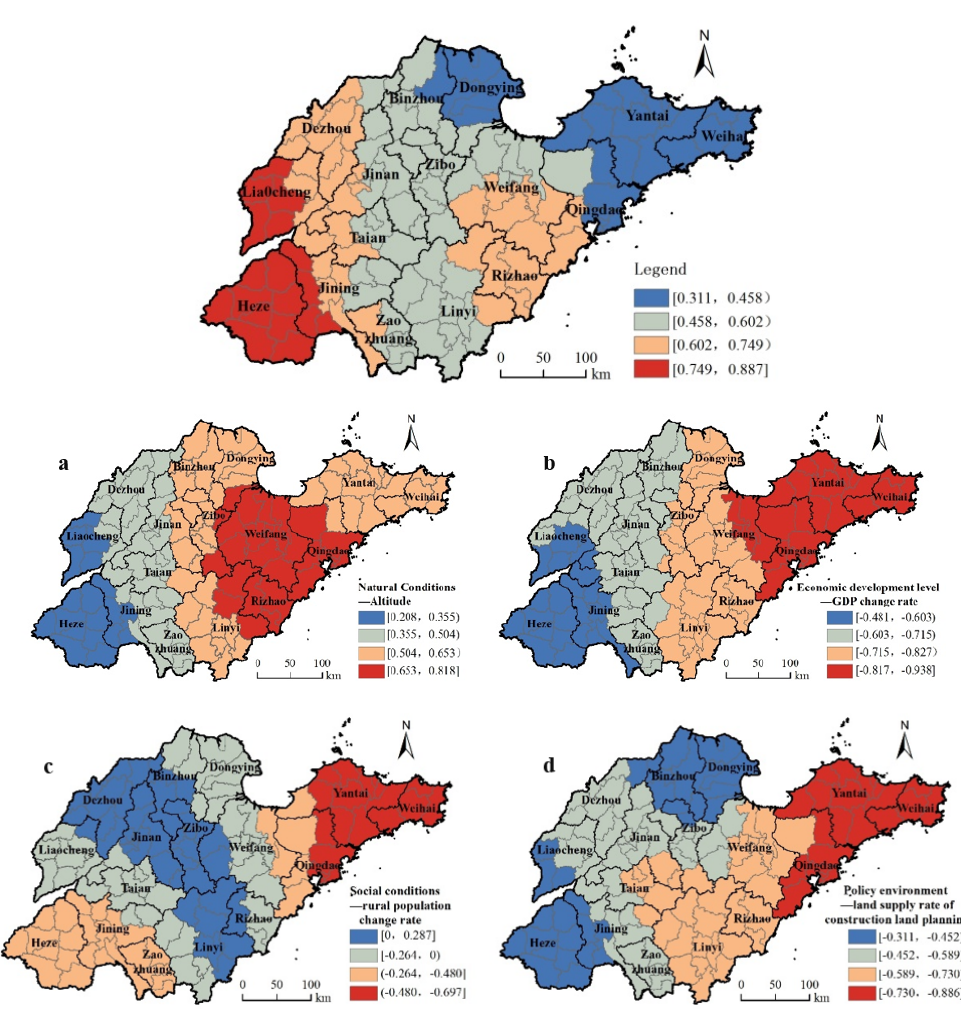
Figure 4. Spatial distribution map of R 2 in the GWR model and distribution maps for the regression coefficients of independent variables in the GWR model. Among them, ( a ) represents the spatial distribution of the impact of altitude on rural residential area transition; ( b ) represents the spatial distribution of the impact of GDP change rate on rural residential area transition; ( c ) represents the spatial distribution of the impact of rural population change rate on rural residential area transition; ( d ) represents the spatial distribution of the impact of land supply rate of construction land planning on rural residential area